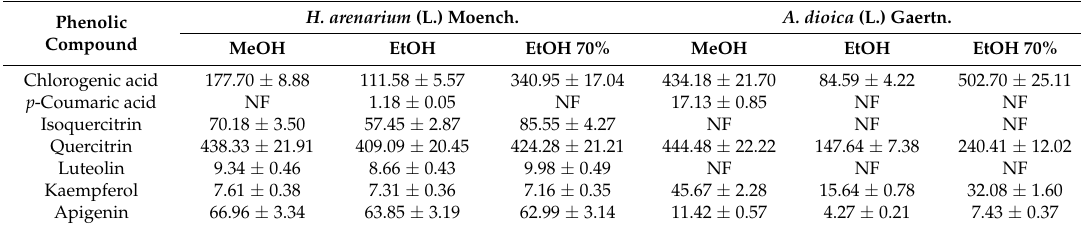
Table 1. The phenolic compounds identified in the flowers of H. arenarium and A. dioica extracts before acid hydrolysis (mg/100 g d.w.).